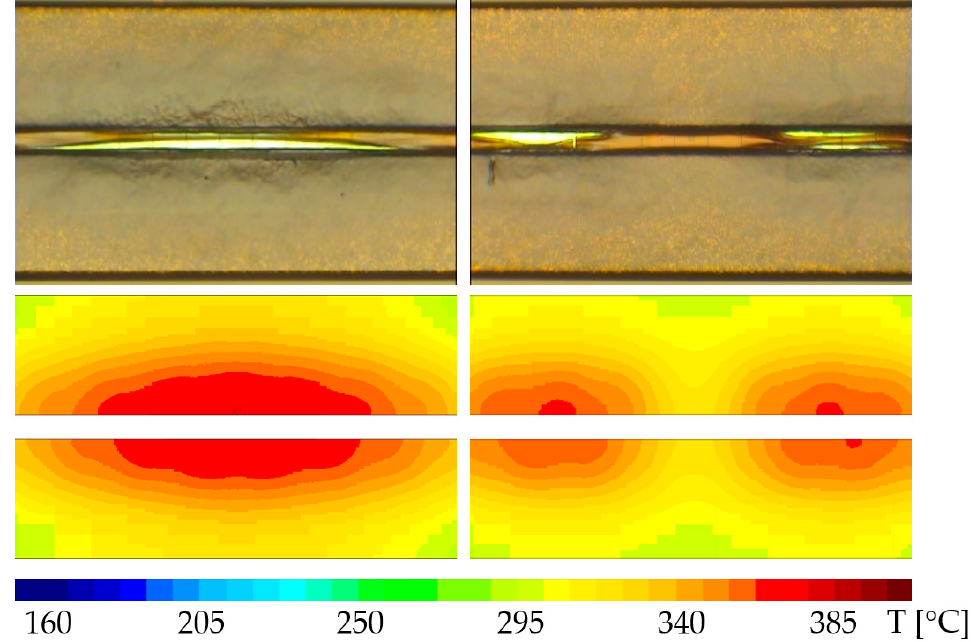
Figure 17. Top: Optical microscopy images for samples operating at 100%AA ( left ) and 90%AA ( right ). Bottom: Simulated temperature distribution in PM plates.